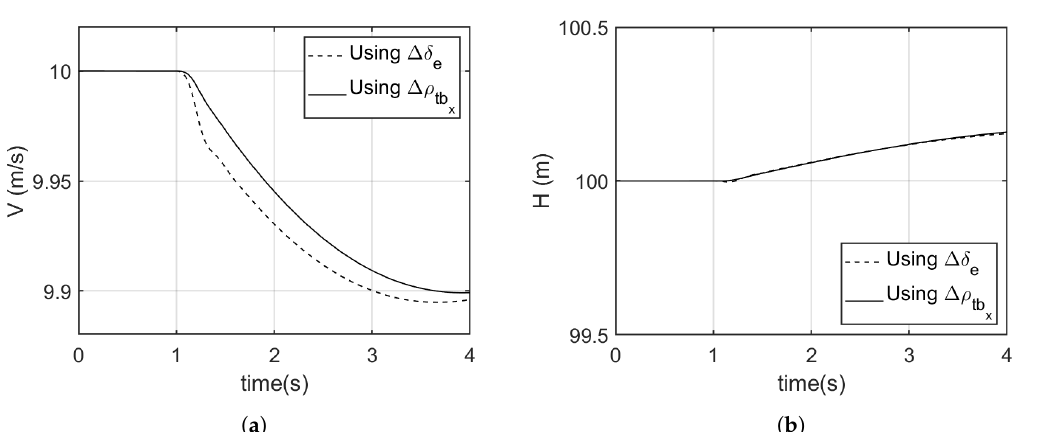
Figure 10. Model 1 aircraft pull up maneuver time response. ( a ) Airspeed. ( b )